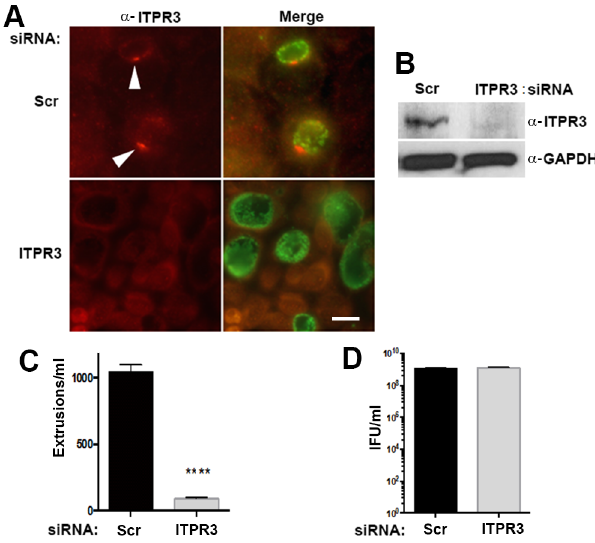
Fig 4. Depletion of ITPR3 inhibits extrusion formation. Hela cells were treated with siRNA corresponding to ITPR3 or a scrambled negative control siRNA (Scr) for 72 hours then infected with C . trachomatis wild-type L2. (A) At 24 hr post-infection, cells were fixed and stained with anti-ITPR3 (red) (Arrowheads) and anti-MOMP (green) to verify the depletion of ITPR3. Bar = 10 μ m. (B) Immunoblots confirmed knock out of ITPR3. (C) Effect on extrusion formation by siRNA depletion of the ITPR3 by siRNA. (D) Effect on total infectious progeny production by siRNA depletion of the ITPR3. Experiments were performed in triplicate (n = 3; error bars represent SEM). The difference was significant (P < 0.0001; (cid:3)(cid:3)(cid:3)(cid:3) ) by an unpaired Students T-test.